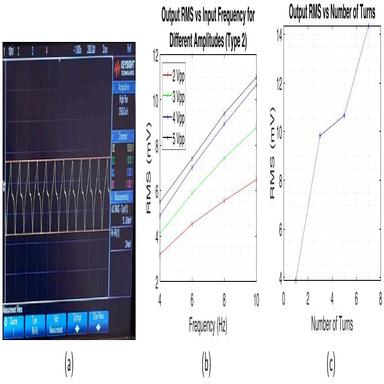
Moving magnet (Type 2) results: a) sample signal received from sensor in oscilloscope at 6 Hz and 3 Vpp; b) output signal RMS for different input frequencies for 5 turns; c) output signal RMS for different numbers of turns at 10 Hz and 4 Vpp.